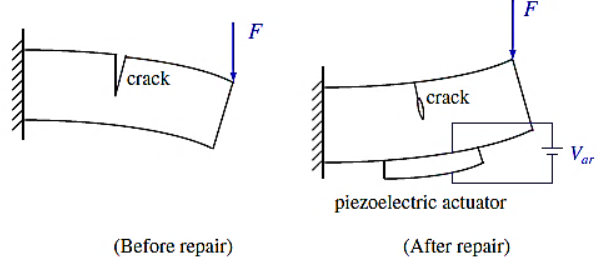
Figure 5. Fracture mechanics criterion for active repair